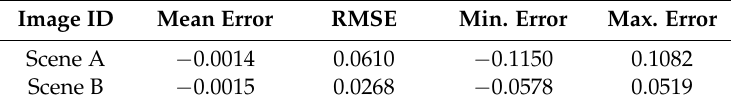
Table 10. Statistical accuracy results (unit: